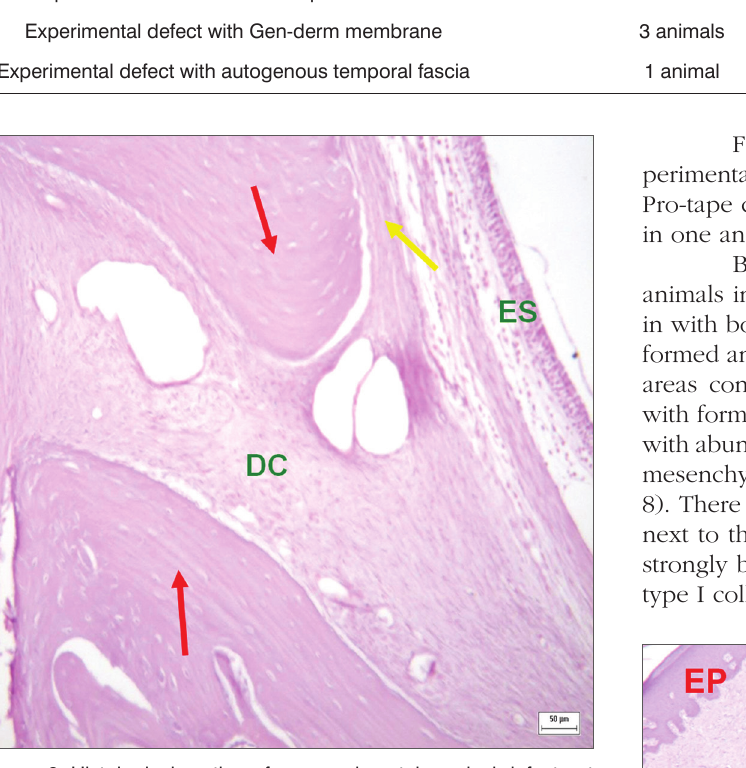
Figure 6. Histological section of an experimental surgical defect not completely filled with bone (hematoxylin-eosin stained) - bone riddges (red arrows); surgical defect (DC) containinig fibrous connective tissue; periosteium (yellow arrow); sinus epithelium (ES).